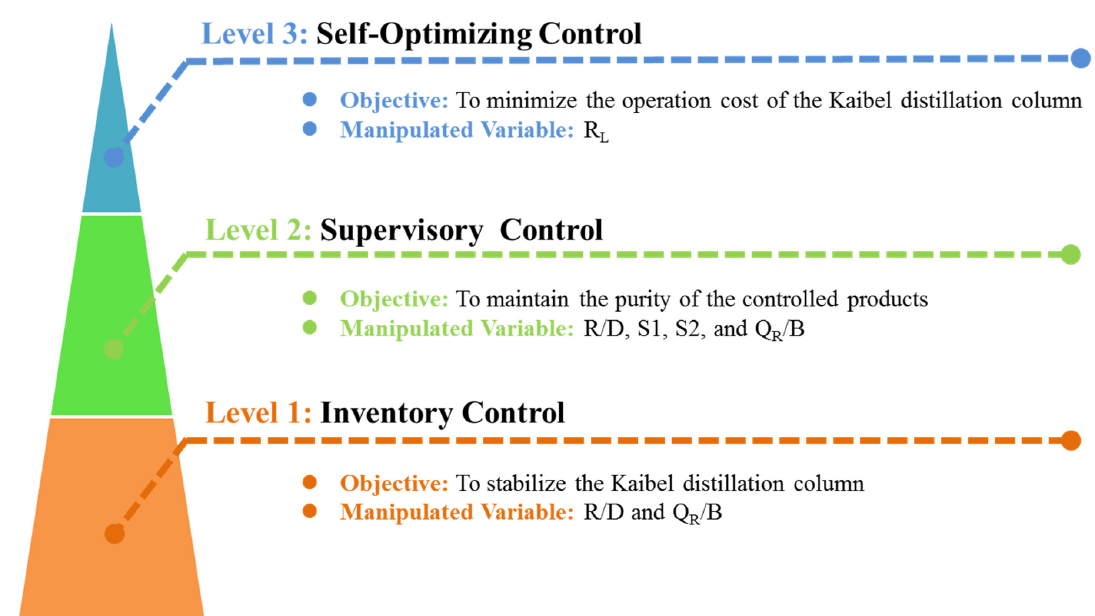
Figure 2. Three levels of the composition control system for the control of the Kaibel distillation column.